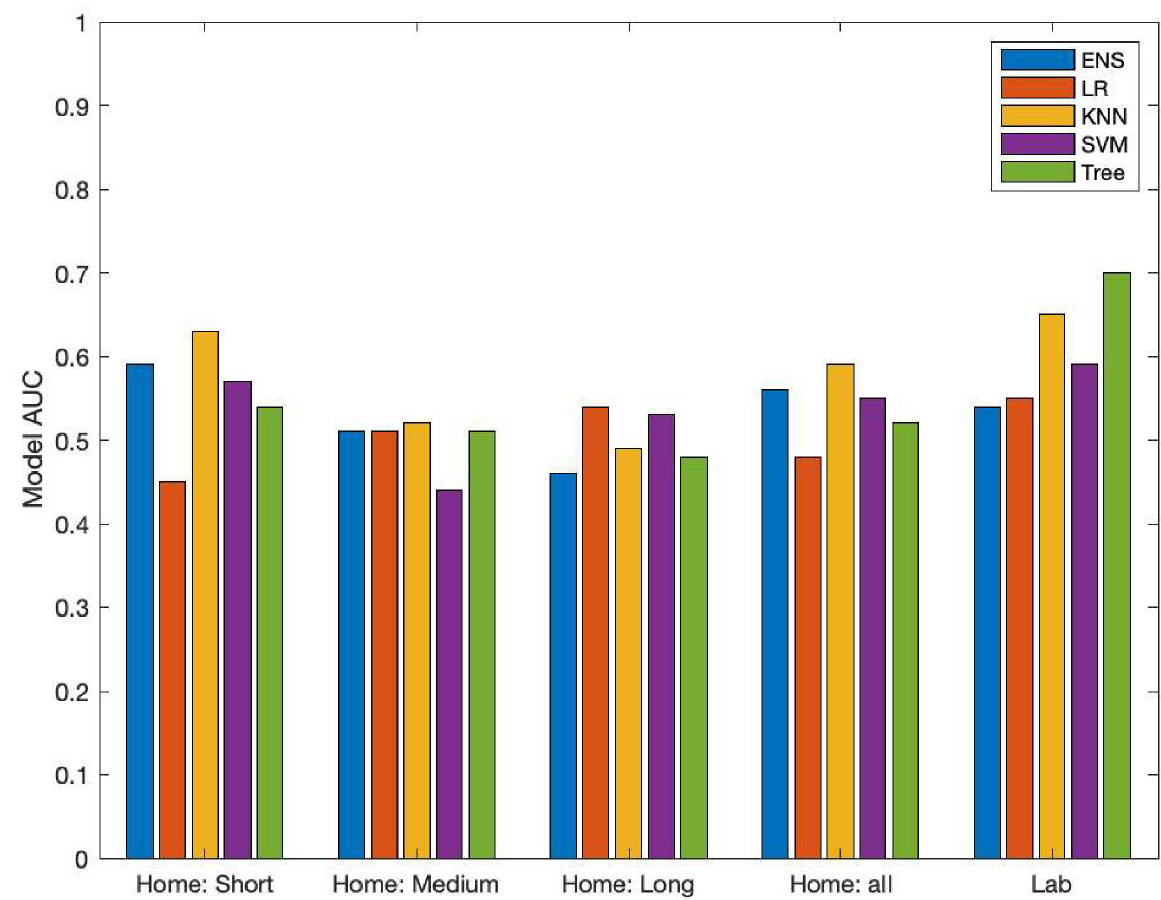
Fig 2. Fall Risk Classification Model AUC for Short Home, Medium Home, Long Home, All Home, and In-Lab Walking Bouts.